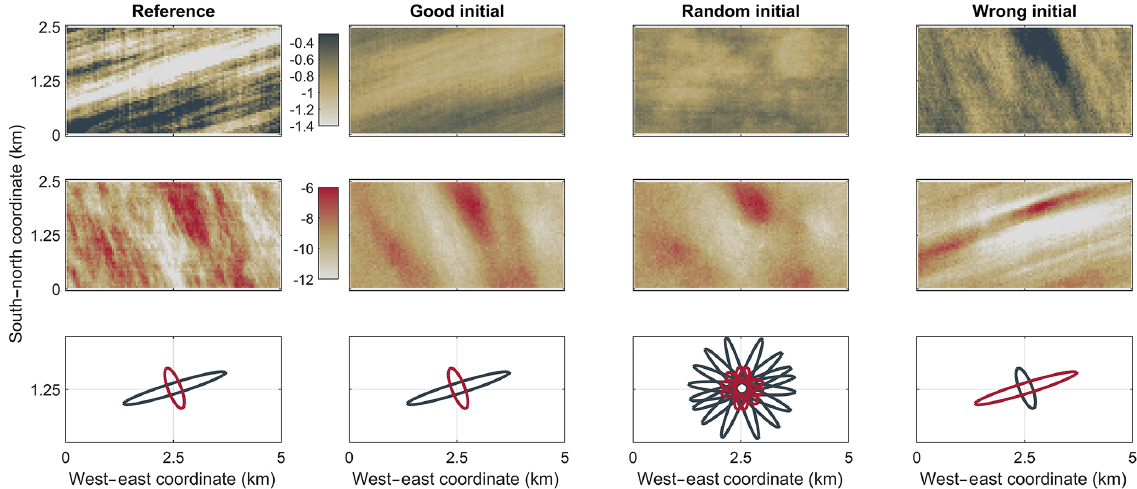
Figure 5. Joint estimation of recharge (top row panels) and conductivity (middle row panels). Shown is the final ensemble mean after all assimilation steps and the covariance functions used to generate the initial ensembles (bottom row panels).